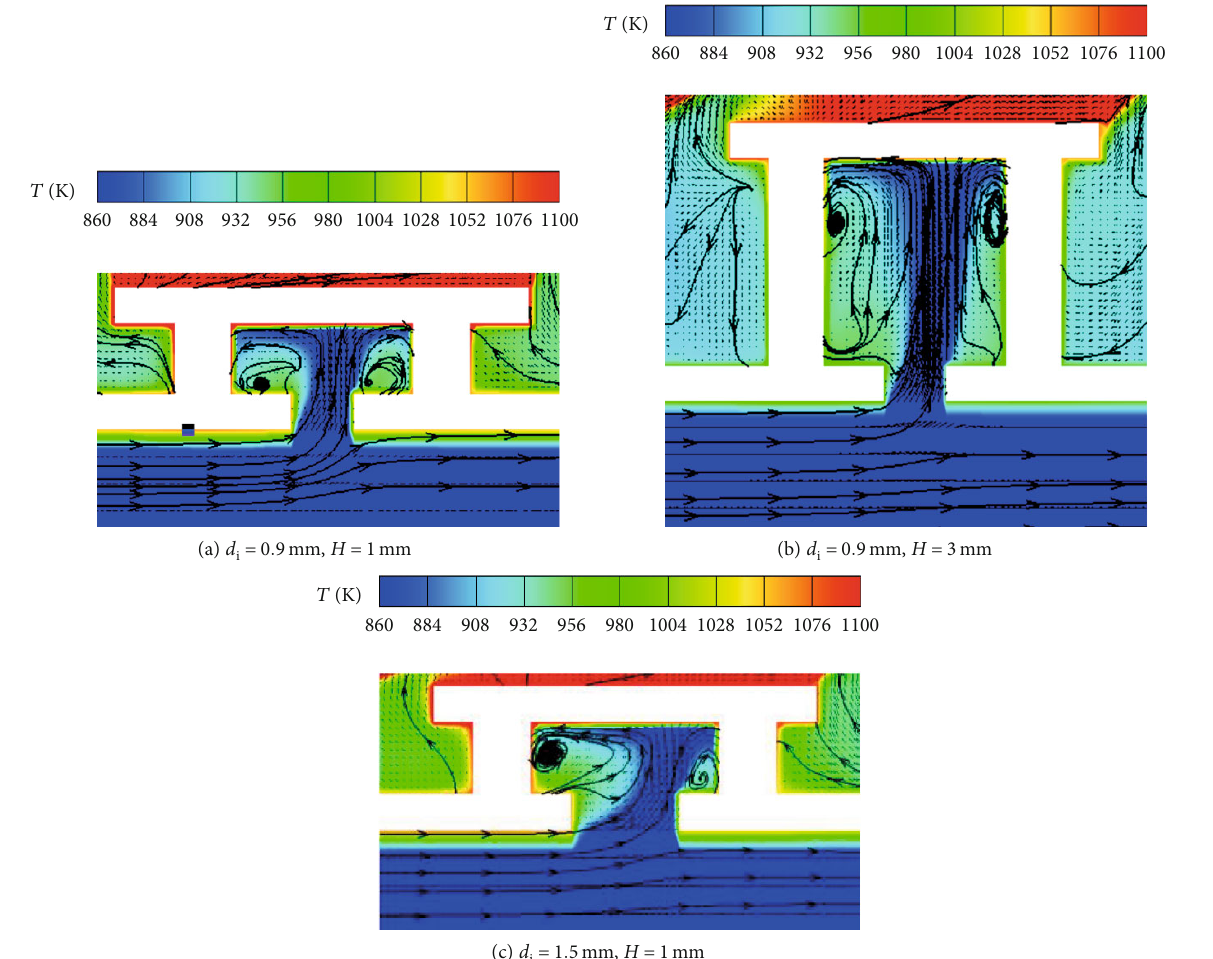
Figure 16: E ff ects of impingement hole diameter and height on streamline distribution on central plane.